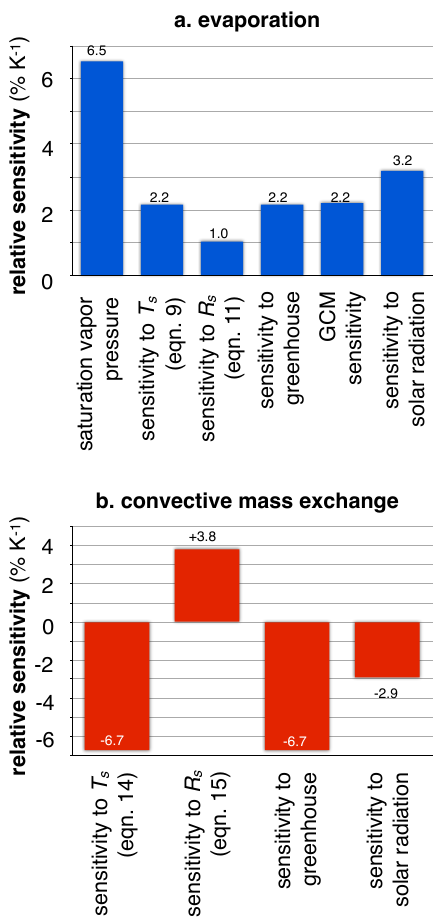
Fig. 2. Sensitivity of (a) the hydrologic cycle (evaporation E ) and (b) convective mass exchange (exchange velocity w ) to differences in surface temperature ( T s ). Shown are the numerical values for the relative sensitivities as given in the text for present-day conditions. Also included in (a) is the sensitivity of saturation vapor pressure, 1 /e sat d e sat / d T s , as well as the mean sensitivity to greenhouse dif- ferences reported for climate models by Held and Soden (2006) (“GCM